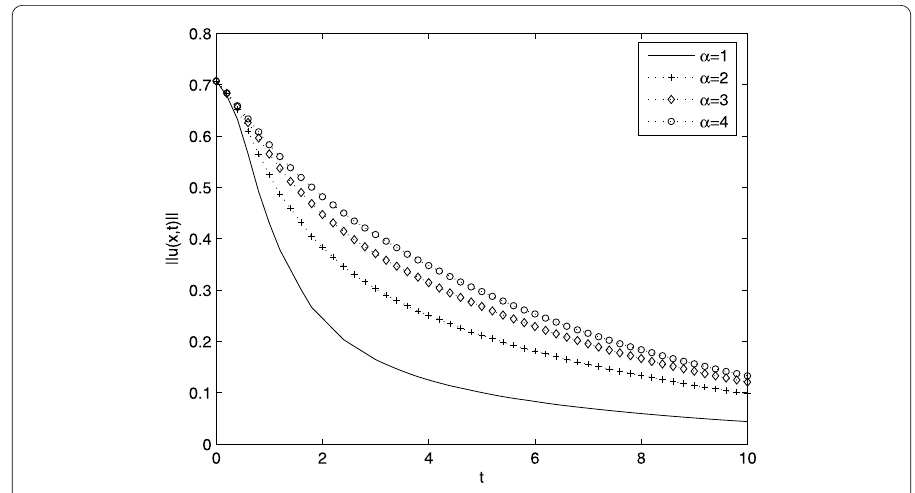
Figure 8 The L 2 -norm of u ( x , t ), (cid:7) u ( x , t ) (cid:7) , versus time for various values of α when using the second nonlinear